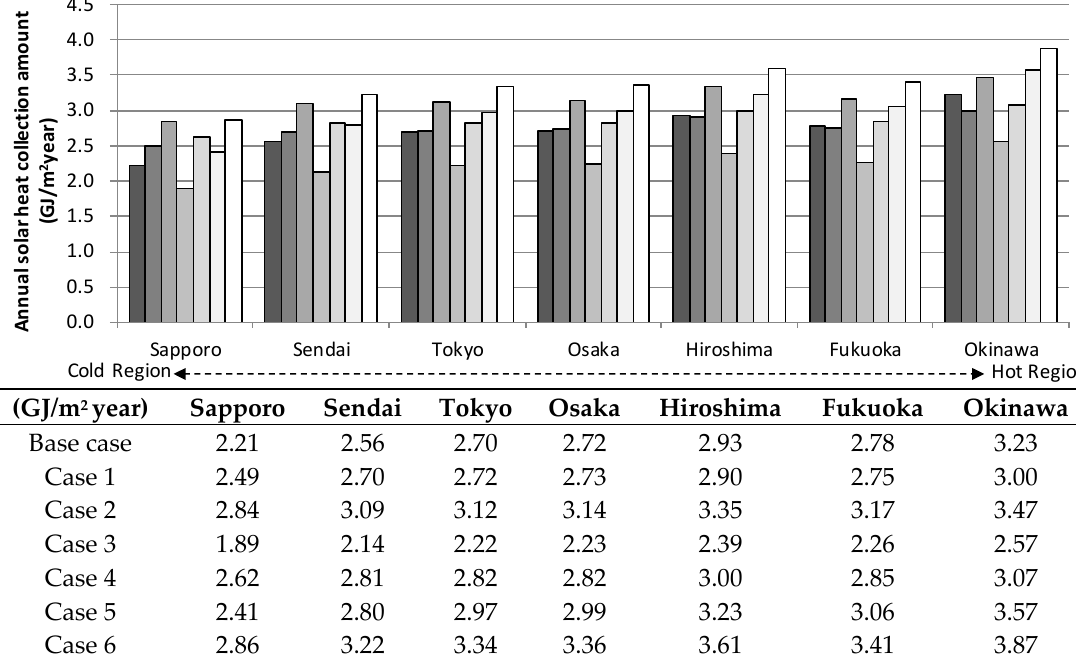
Figure 8. Amount of the solar collection per unit area under seven different weather conditions.